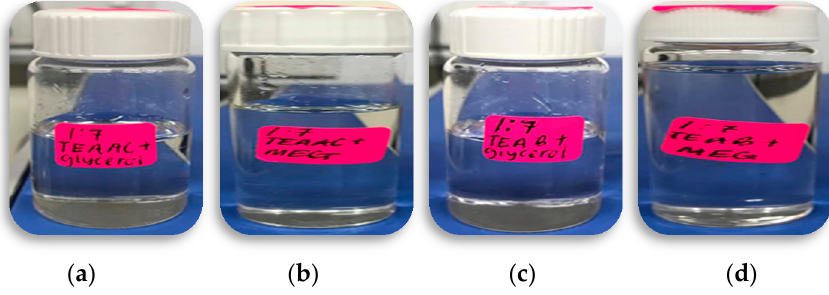
Figure 2. Deep Eutectic Solvents in respective beakers. ( a ) TEAAC:Glycerol, ( b ) TEAAC:MEG, ( c ) TEAB:Glycerol, and ( d ) TEAB:MEG.